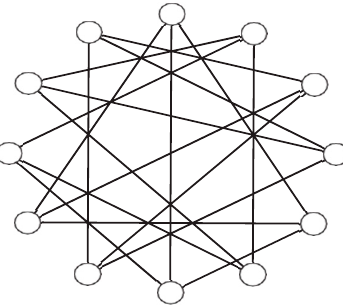
Figure 11. A cubic co-distance graph of diameter 4 with non-zero H -entropy.